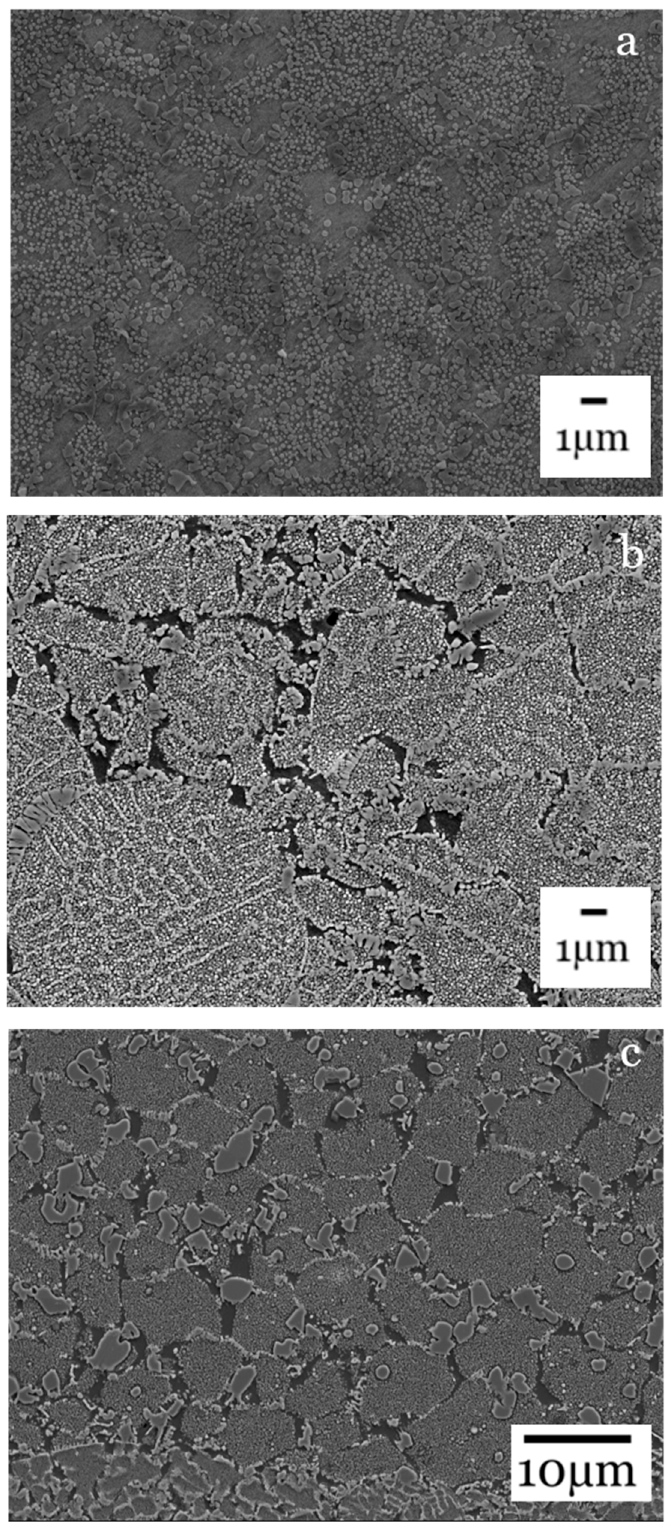
Figure 8. FEG-SEM of bondlines: ( a ) bond 1, ( b ) bond 2, ( c ) bond 3 .